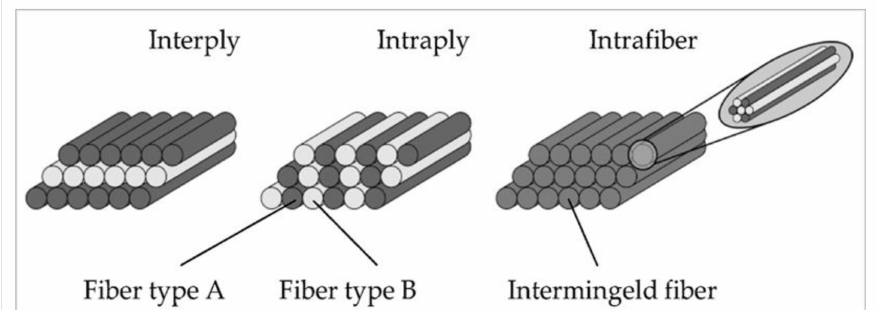
Figure 1. Hybrid configurations for continuous and discontinuous fibre reinforced composites: interply, intraply and intermingled adapted from [62] MDPI,